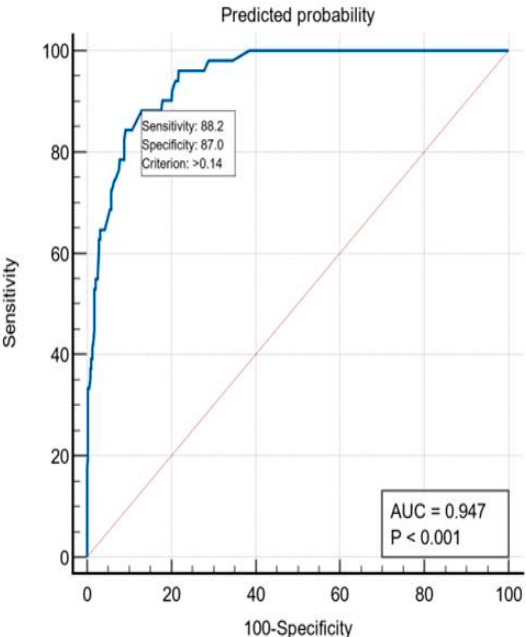
Figure 5. ROC curve of the multivariate logistic regression model.